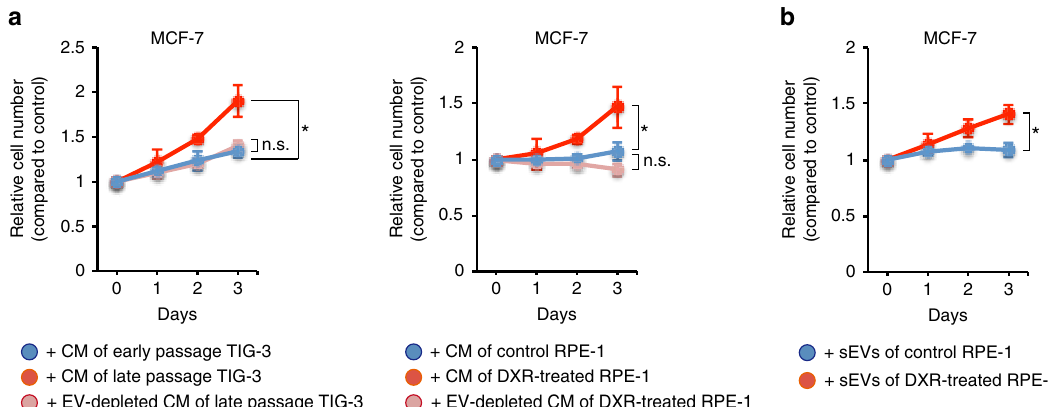
Figure 2 | sEVs secreted from senescent cells promote the proliferation of MCF-7 cells. ( a ) Relative numbers of MCF-7 cells grown in the presence of CM compared with the number of cells grown in normal medium (DMEM supplemented with 10% FBS). CM was prepared from control (early passage) and replicative senescent (late passage) TIG-3 cells, or control and DXR-induced senescent RPE-1 cells, and was used directly or after depleting EVs by ultracentrifugation. Cell densities of early and late passage TIG-3 cells were 8 (cid:2) 10 2 cellscm (cid:3) 2 at 1day before starting CM preparation. Cell densities of control and DXR-induced senescent RPE-1 cells were 1.4 (cid:2) 10 4 cellscm (cid:3) 2 at 1day before starting CM preparation. MCF-7 cells were plated at a density of 4 (cid:2) 10 2 cellscm (cid:3) 2 1day before starting the experiments. The basal proliferation rate, that is, the fold increase in cell number of untreated MCF-7 cells